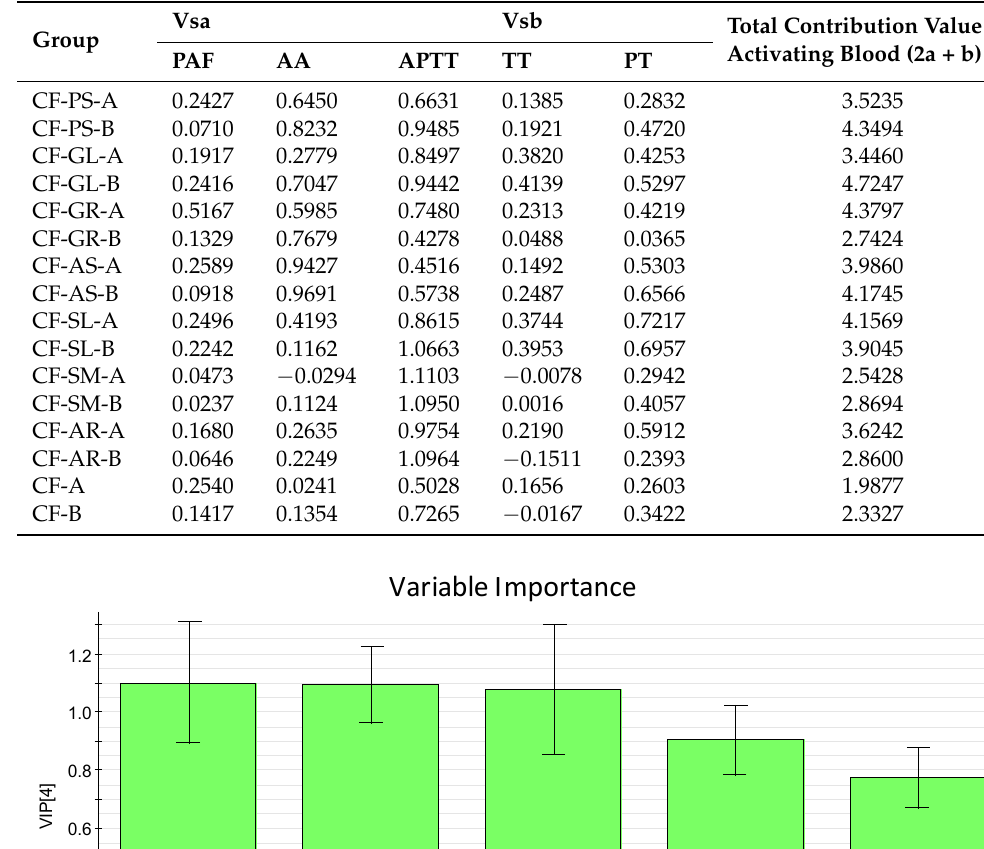
Table 4. Total effect changes of activating blood in safflower series of herb pairs.